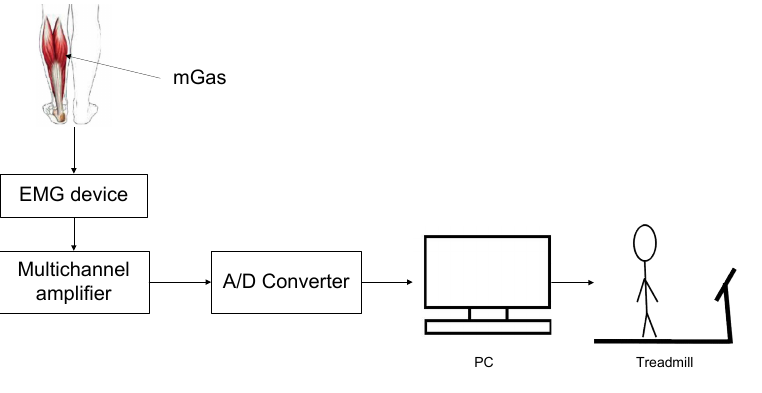
Figure 2. Experimental setup during surface EMG data recording. A/D: analog-to-digital; mGas: gastrocnemius